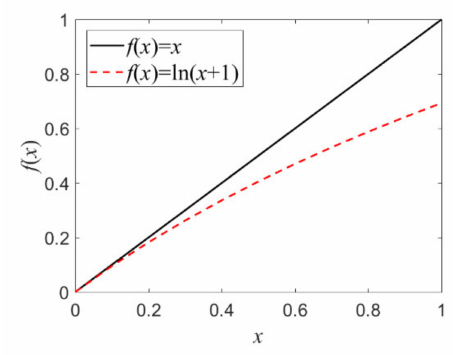
Figure 3. Comparison between the linear function f ( x ) = x and the natural logarithm function f ( x ) = ln ( x + 1 ) in compressing data